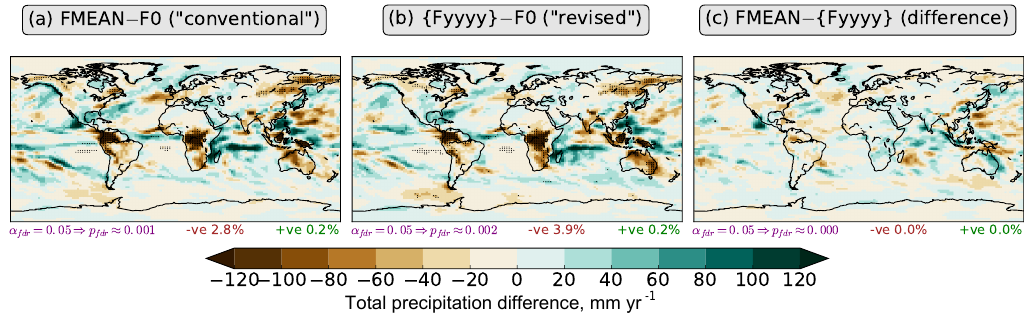
Figure 8. Total (large-scale plus convective) annual precipitation differences for (a) simulation FMEAN relative to simulation F0, (b) the { Fyyyy } ensemble relative to simulation F0, and (c) the FMEAN −{ Fyyyy } difference. Stippling indicates differences that are statistically significant at a significance level of α fdr = 0 . 05 after controlling the false discovery rate (FDR; Benjamini and Hochberg, 1995; Wilks, 2016). The two-tailed p values are generated by Welch’s t test, using annual mean data as the input. The approximate p value threshold, p fdr , is written in purple underneath each map. The percentage of the globe (area-weighted) over which negative ( − ve) statistically significant differences occur is written in brown text underneath each map, while the percentage of the globe over which positive ( + ve) statistically significant differences occur is written in green